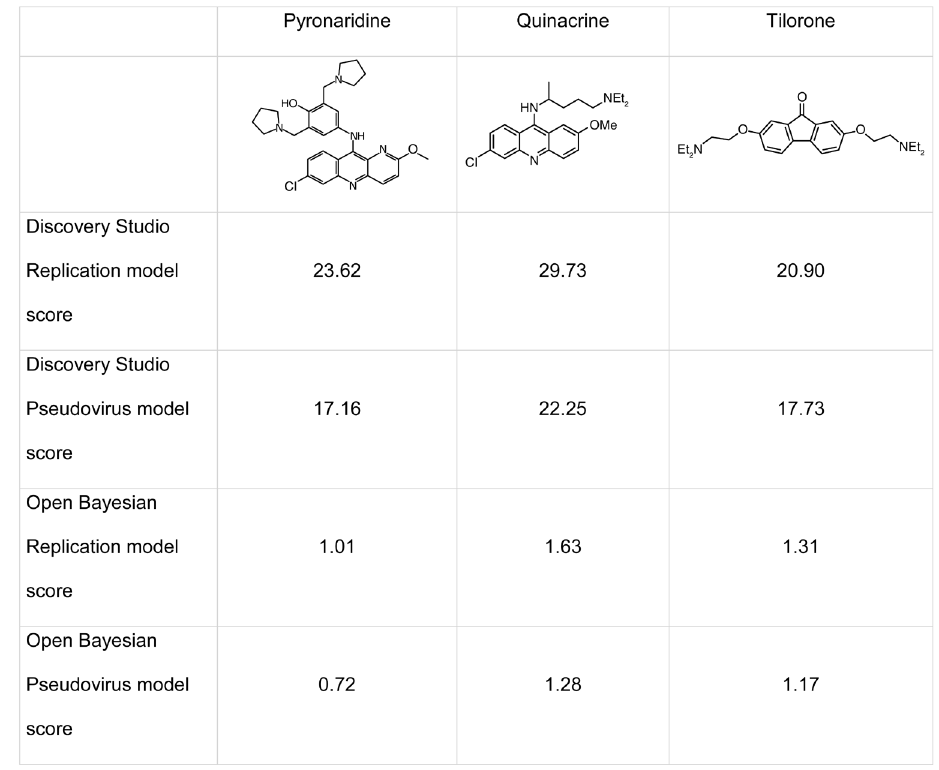
Figure 3. Molecules scoring well with the Ebola Bayesian models. For comparison, chloroquine scored 31.38 in the replication Discovery Studio Bayesian model, 24.55 in the Discovery Studio Pseudovirus Bayesian model, 1.63 in the Open Bayesian Replication model and 0.51 in the Open Bayesian Pseudovirus